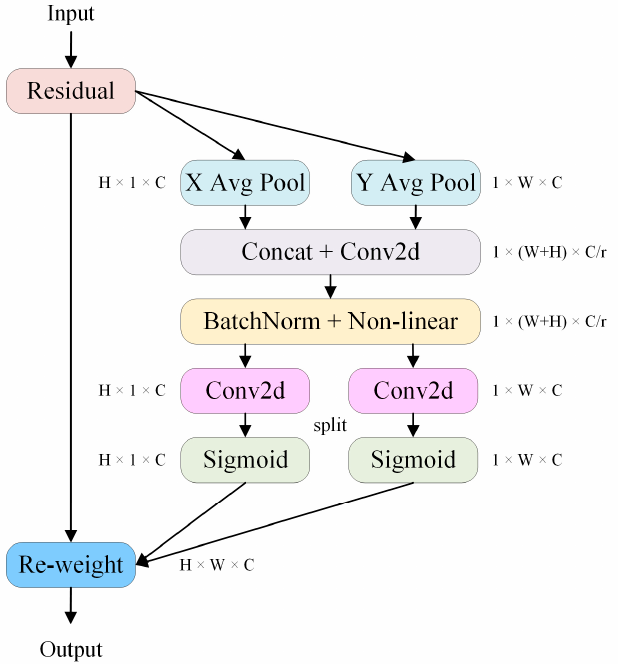
Figure 7. Coordinate Attention